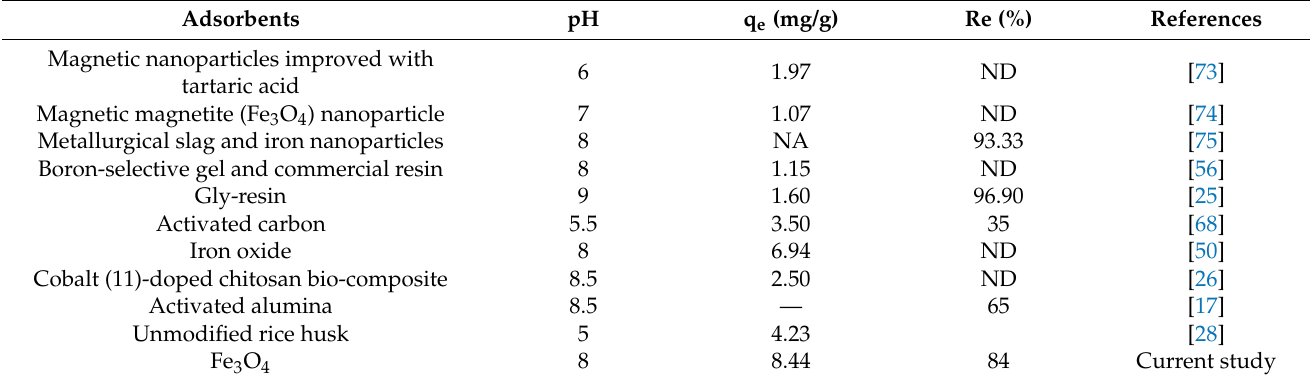
Table 2. Comparison of boron adsorption capacities for various